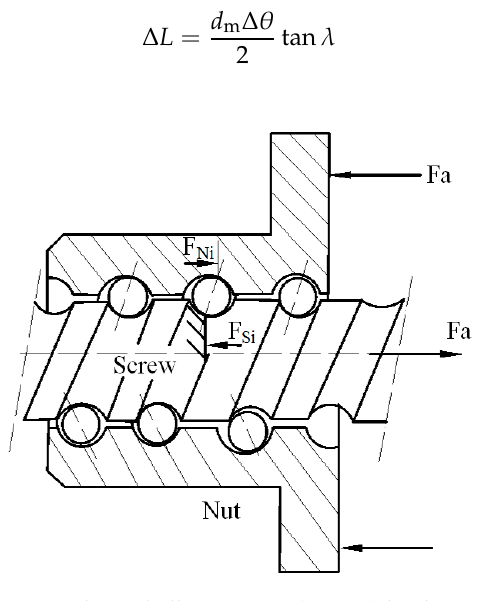
Figure 4. Single nut ball screw pair (SNBSP) load condition.